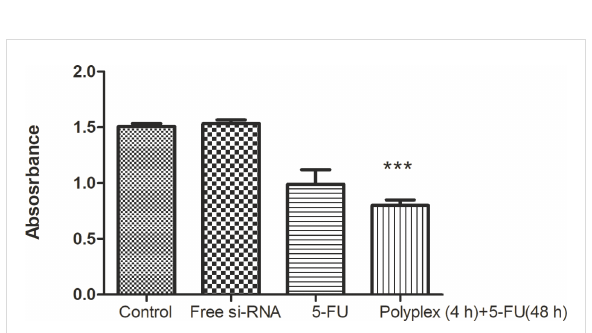
Also, Boyden chamber assay measurements were carried out (Figure 11) in which the same trends were observed.